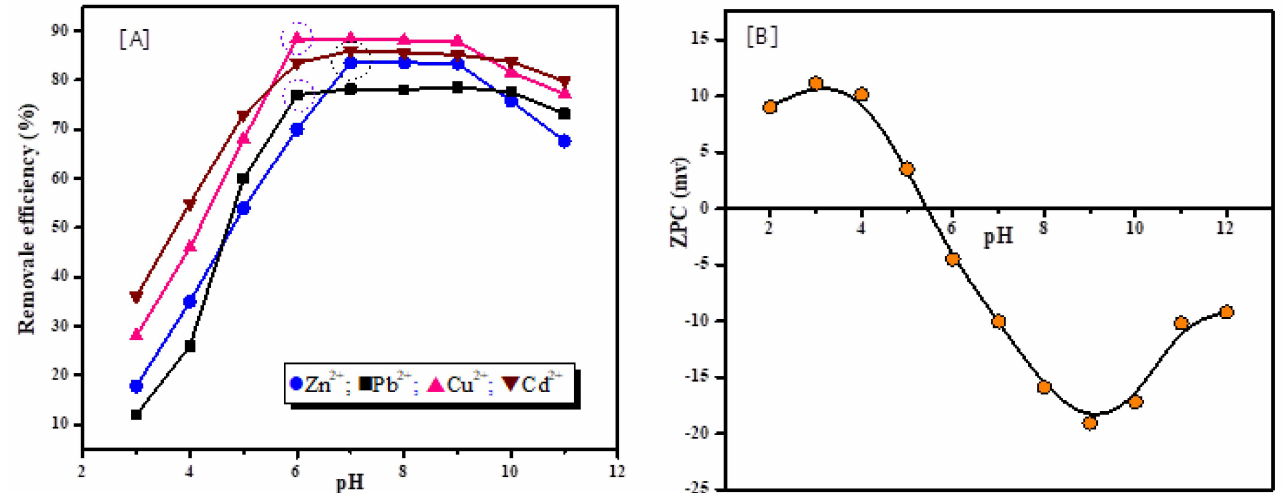
Figure 5. Effects of pH values on the adsorption efficiency of Zn 2+ , Pb 2+ , Cu 2+ , Cd 2+ metal ions on the adsorbent surface ( A ), Point of zero charge (PZC) of synthesized zeolite ( B